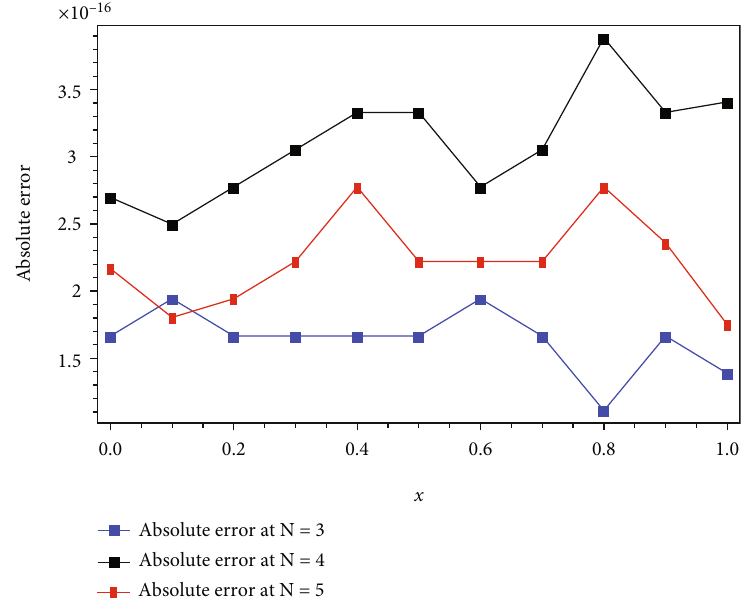
Figure 1: The behavior of the absolute errors for the proposed method with N = 3, 4, 5 for Example 1.